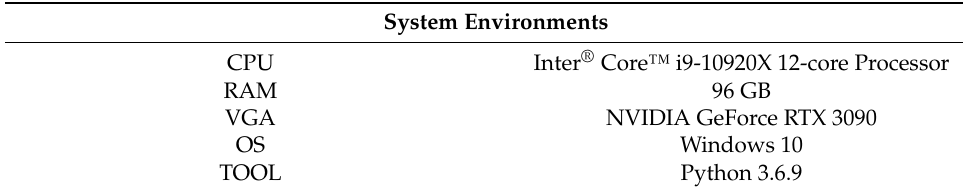
Table 1. System Environments.